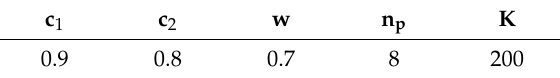
Table 2. Parameters for the FSBPSO